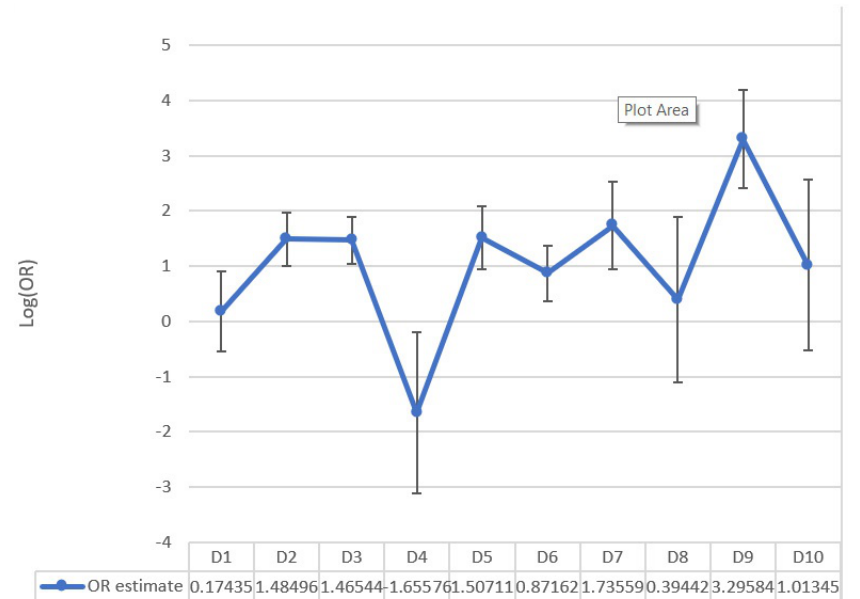
Figure 7. A summary of odds ratio log for each class of drugs vs. no drugs.